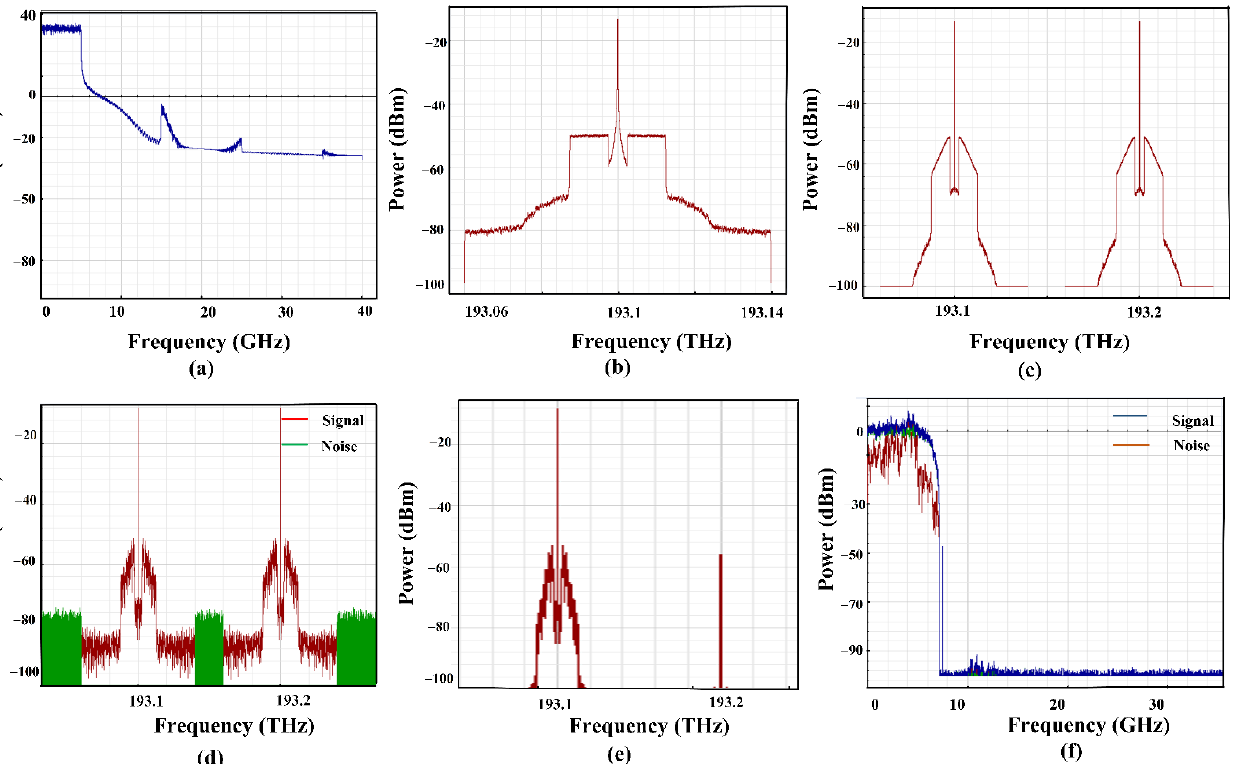
Figure 4. Spectrum diagram of ( a ) OFDM modulated signal, ( b ) signal after the LiNbO3 MZM, ( c ) the multiplexed signal, ( d ) signal after 50 km MMF, ( e ) the de-multiplexed signal at 193.1 THz; ( f ) the received OFDM signal.